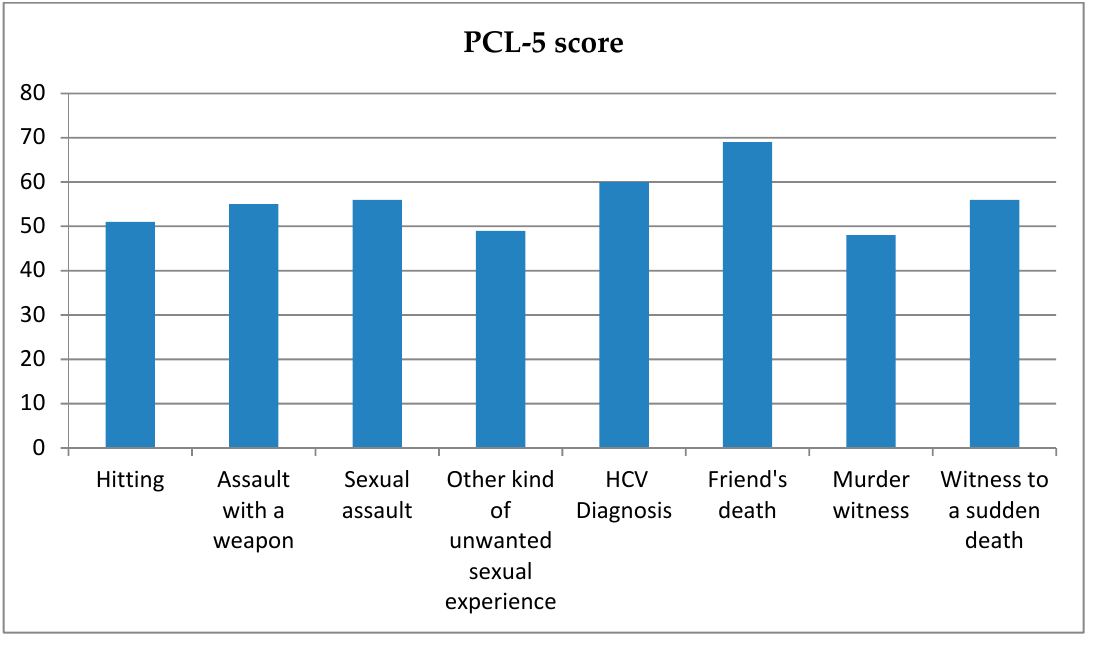
Figure 1. Previoustraumatic events and PCL-5 score .